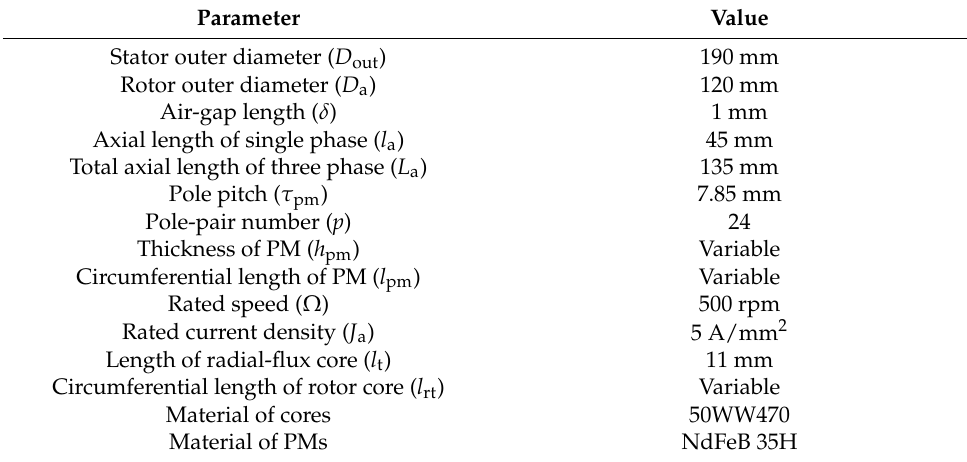
Table 1. Design dimensions and materials of TF-CFRM.